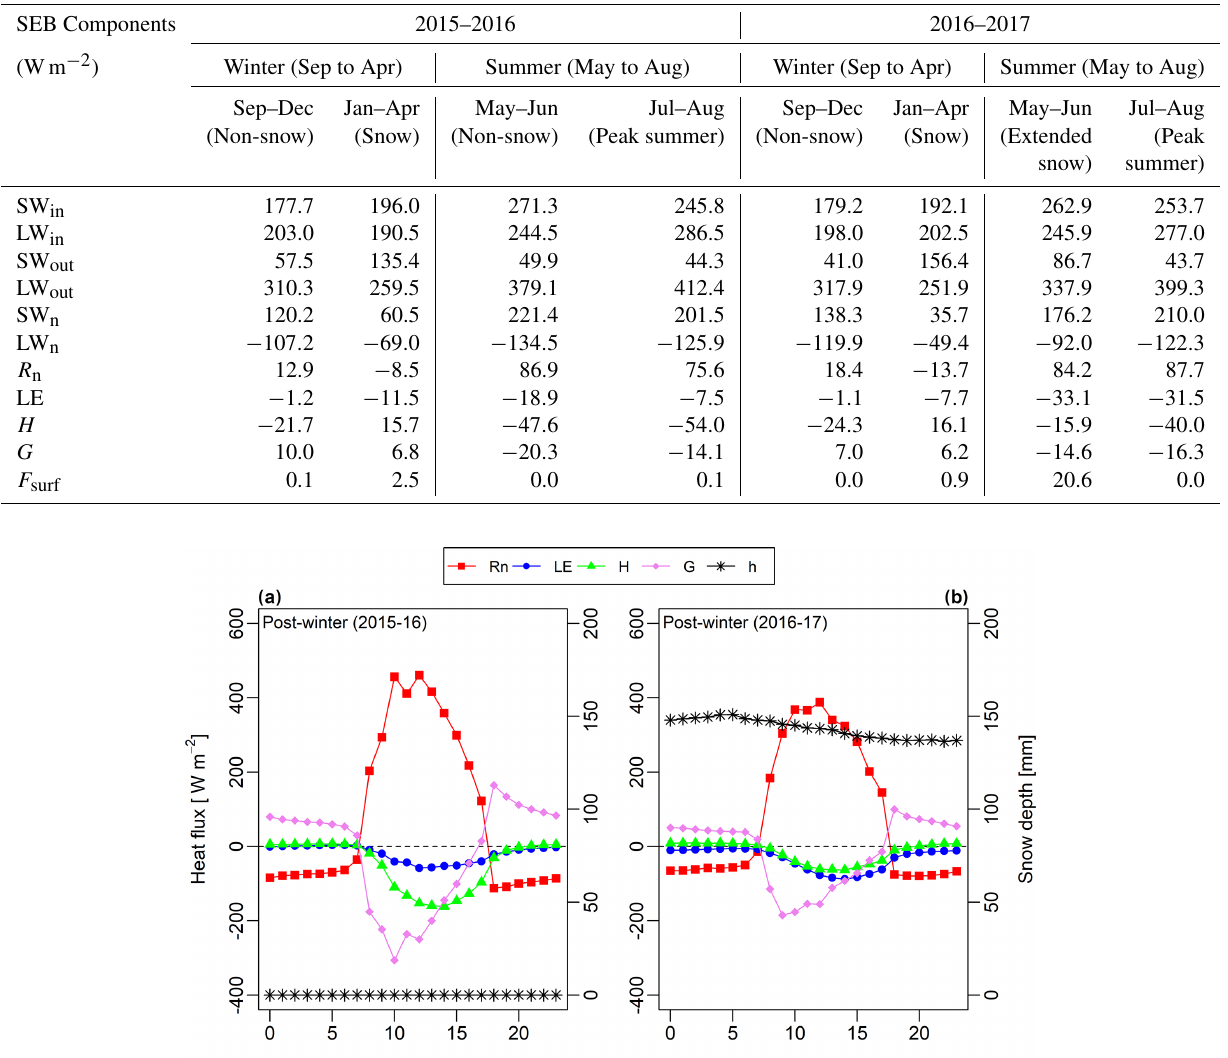
Table 4. Mean seasonal values of observed radiation and modelled surface energy balance components. SEB Components